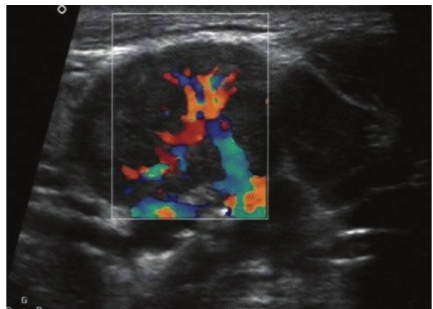
Figure 3: Lesion within left parotid on colour doppler study; shows significant vascularity.